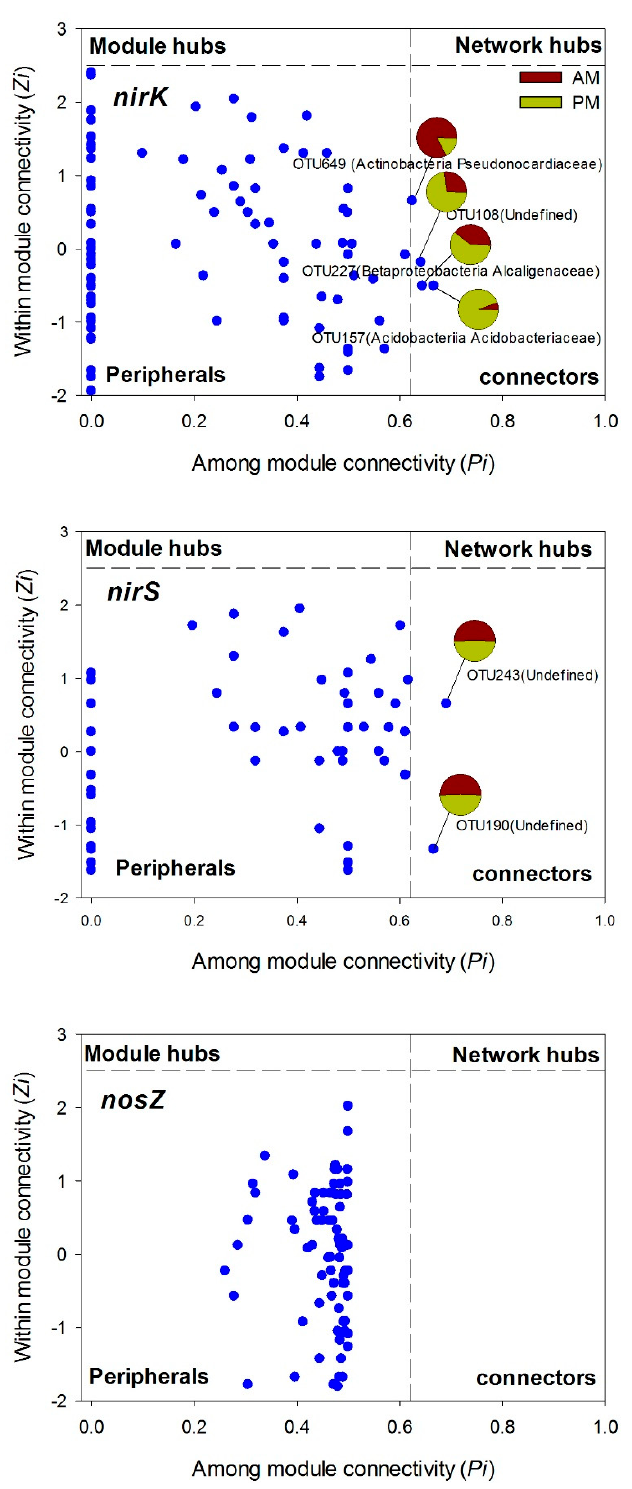
Figure 4. Zi - Pi plots showing the topological distribution of OTUs in the nirK and nosZ gene containing bacterial networks. The keystone species (module hubs and connectors) are marked by OTU number, and the proportion of the total number of each keystone species detected in the Acacia mangium (AM) and Pinus massoniana (PM) plantations are shown in the pie charts (i.e., the number of OTUs in AM or PM plantations divided the total OTU numbers detected in both types of plantations).